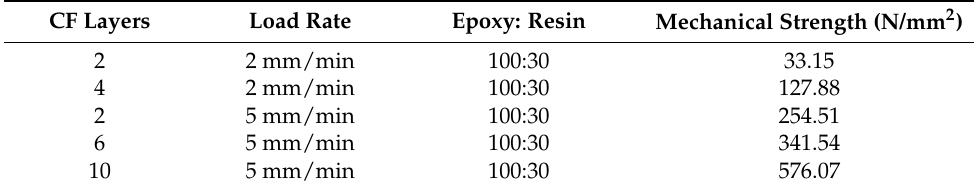
Table 4. Mechanical Strength of Tested Carbon-fiber